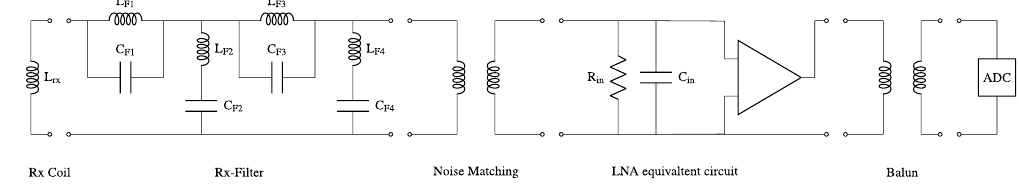
Figure 2. Circuit model of the receive chain used. The remaining direct feed-through signal that is not suppressed by the gradiometer is filtered by a 4th order resonant passive filter. The signal is then noise matched and transformed in a differential signal for the analog digital